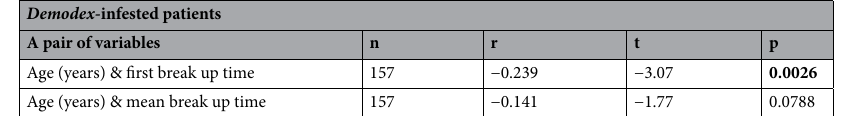
Table 7. Descriptive statistics of the mean break up time in both eyes in patients with and without Demodex infestation and results of the t-test with Cochran–Cox correction. Arithmetic mean (M), standard deviation (SD), interquantile range (Q25–Q75), degrees of freedom (df), t-value (t), p-value (p).